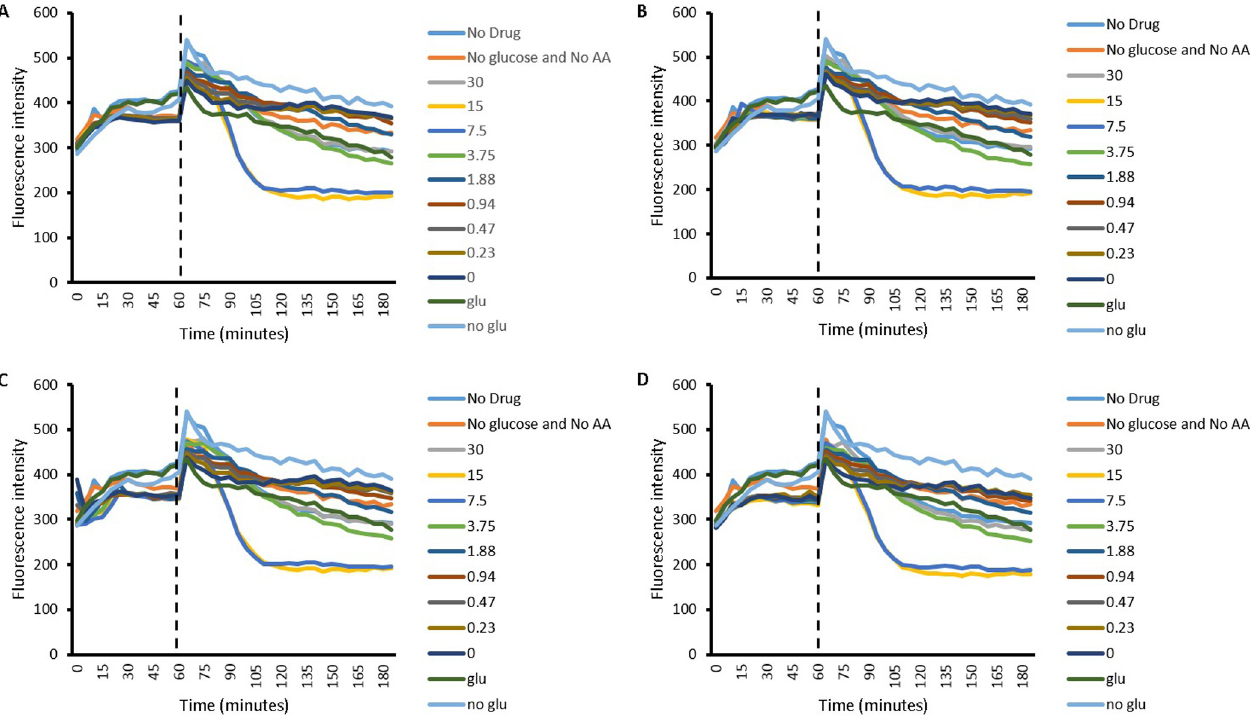
Fig 2. Efflux of EtBr by S . aureus in the presence of different concentrations of L-Glu (30 mM to 0.23 mM). A) 8.49 μ M Cip B) 4.24 μ M Cip C) 2.12 μ M Cip D) 1.06 μ M Cip. In the legend, numbers 0 to 30 represent amino acid concentrations in combination with respective Cip concentration. Firstly, the dashed line represents end of the first part of experiment where Cip and EtBr was allowed to accumulate within energy deprived cells and secondly the start of accumulation in the presence of the amino acid, with or without energy; n = 4.